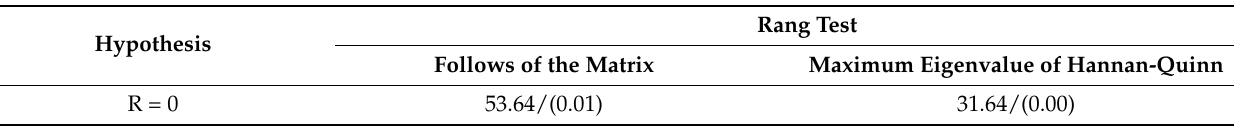
Table 5. The findings of the cointegration analysis between the selected parameters using the Johansen test for Ukraine in 2002–2019 (source: developed by the authors).